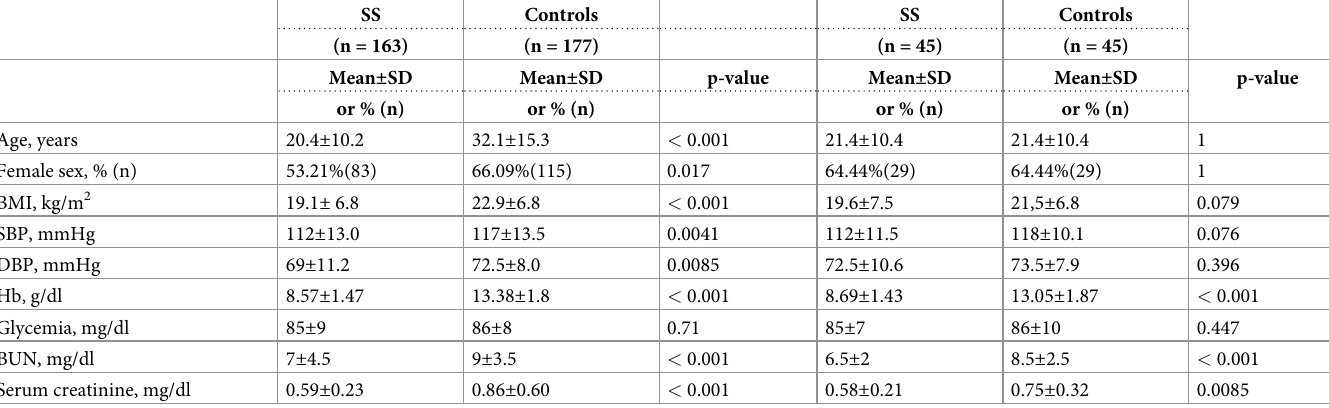
Comparison of prevalence of biological indices abnormalities between SCA patients and unmatched controls showed that SCA was associated with kidney dysfunction ‘‘Table 4“. The following proportions of abnormal biological indices of kidney dysfunction were observed in SCA patients versus controls, as follows: hyposthenuria: 35.3% versus 5.2% (p < 0.001); Table 3. Comparison of means of anthropometric and biochemical parameters between sickle cell anemia patients and unmatched controls and then age- and sex- matched controls. SS Controls